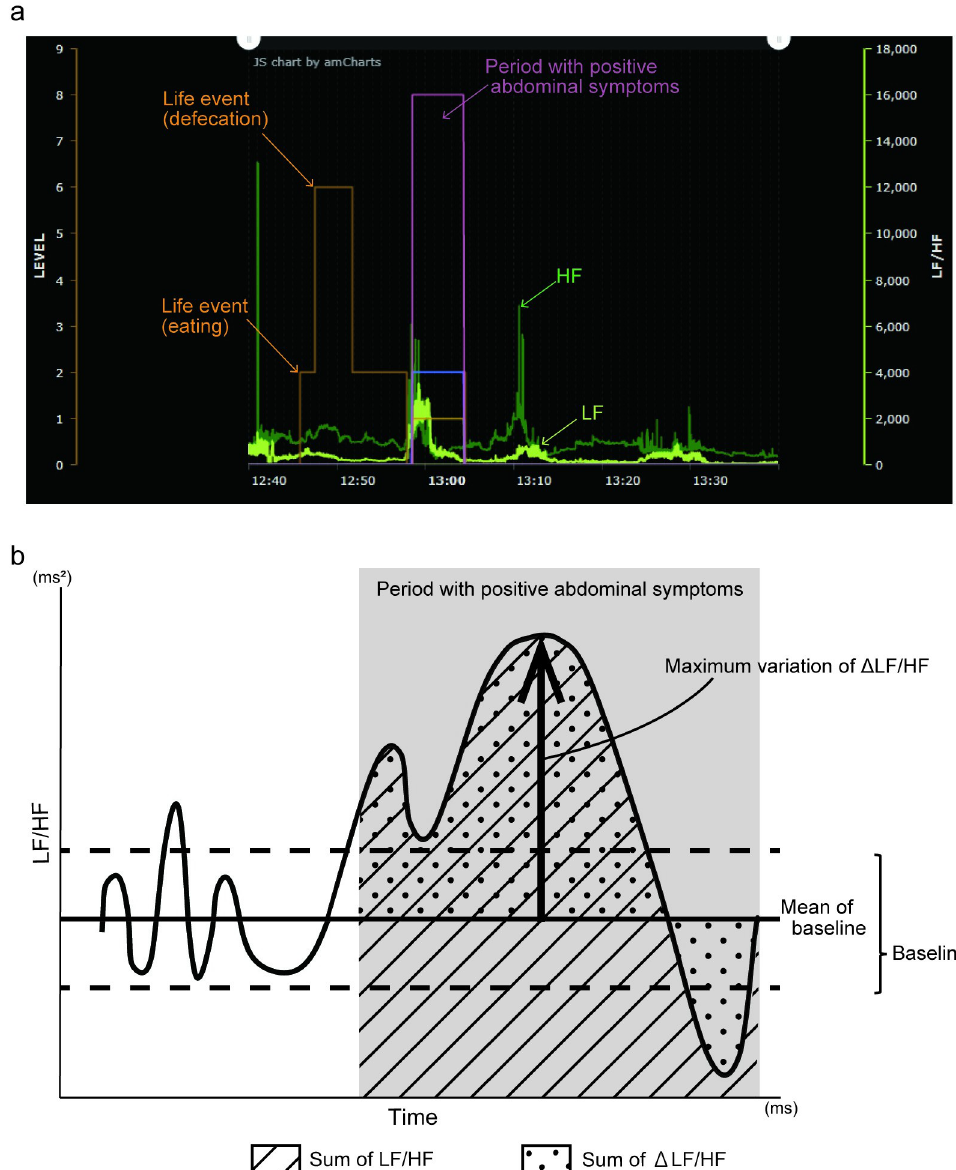
Fig 2. The graph of obtained data and measuring method of ANS activity. (a) The real graph of obtained data about autonomic nervous system (ANS) activity and life events. The results of low frequency (LF) (yellow line) and high frequency (HF) (green line) represented in a graph. Life events, such as defecation and eating (the enclosed area with orange line) and period with positive symptoms (the enclosed area with pink line), were recorded. (b) Measuring method of ANS activity. The baseline LF/HF was defined as the value included in the range of the mean ± 2 standard deviations (dashed line) of LF/HF measured in the period with no symptoms. The sum of LF/HF was the area under the curve of LF/HF measured in the period with positive symptoms (upward diagonal). The sum of Δ LF/HF was the sum of variation from the mean value of baseline measured in the period with positive symptoms (dots). The maximum variation of Δ LF/ HF indicated the maximum variation from the mean value of baseline measured in the period with positive symptoms (arrow). HF was analyzed in the same